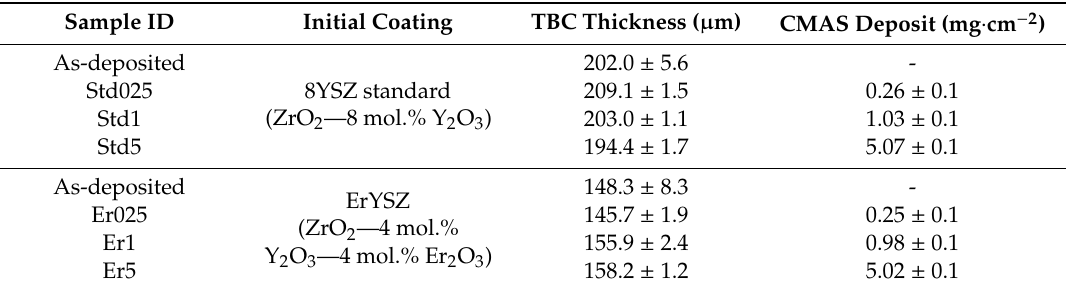
Table 1. Samples of the